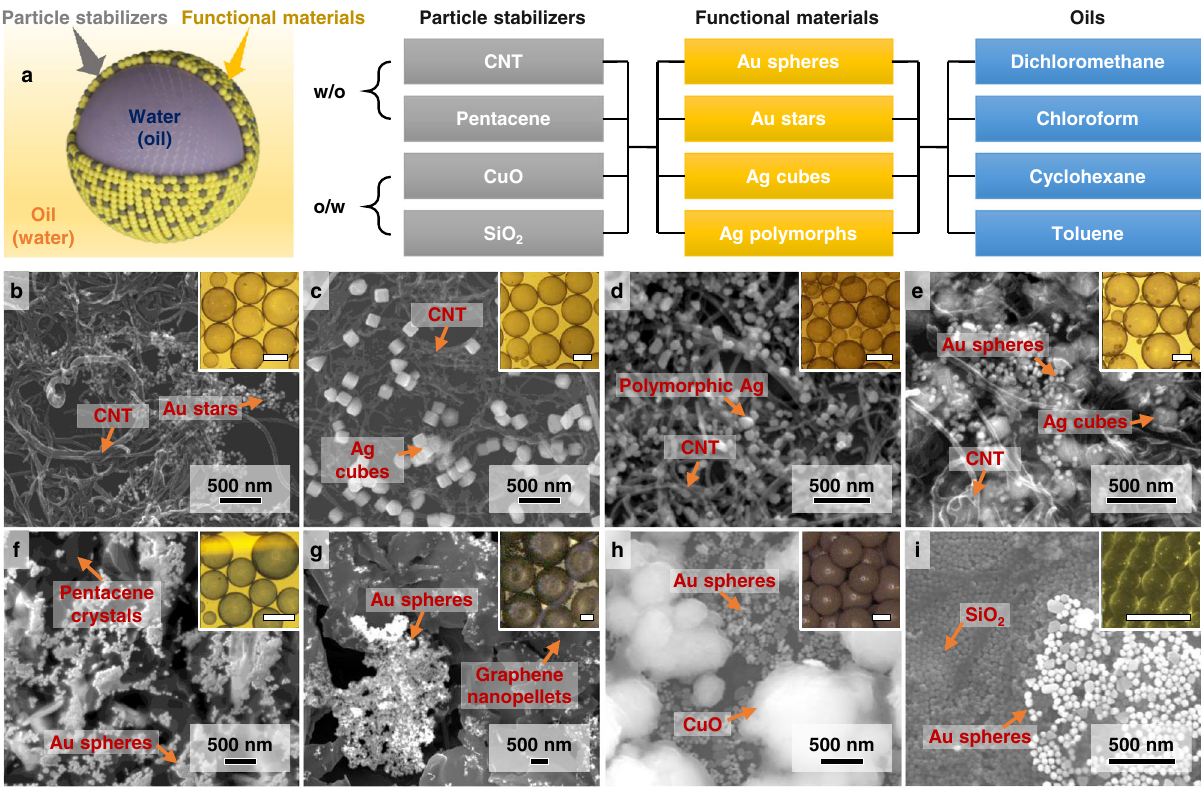
Fig.4|ExpandingPickeringemulsiontypesviapromoterassistedco-assembly. a Schematic illustrations showing the key interchangeable components within the promoter assisted co-assembly of Pickering emulsions. b – i SEM of the mixed NP layerinemulsionsstabilizedwithCNTsandAunanostars;CNTsandAgnanocubes; CNTsandpolymorphicAgnanocrystals;CNTs,AunanospheresandAgnanocubes;